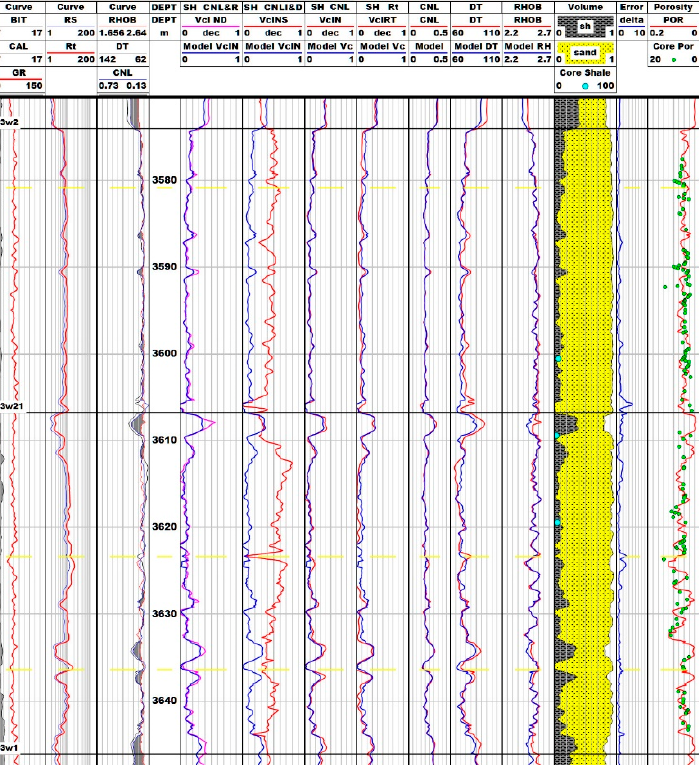
Figure 9. Comparisons between the logging curves (blue) calculated by the optimized volume model and the original curves (red). The purple curve is the clay content calculated by density-neutron crossplot. The green points are the core porosity. The rose curve is the